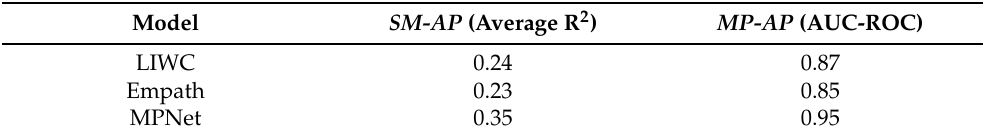
Table 6. Comparison of our model with the baseline